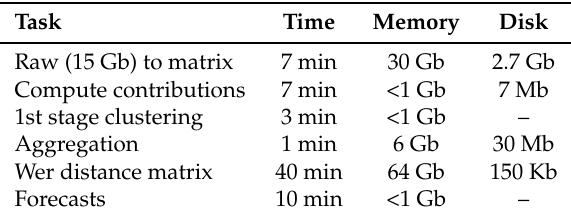
Figure 9. Code profiling by